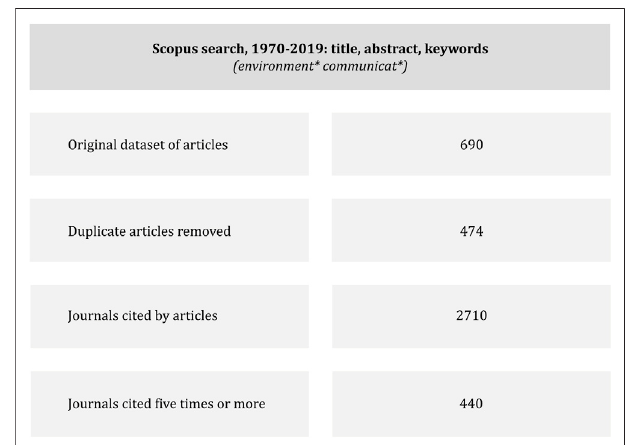
FIGURE 1 | The search process generated both an original set of 474 environmental communication articles and aset of440journals cited bythose articles 5 times or more within the years 1970 –